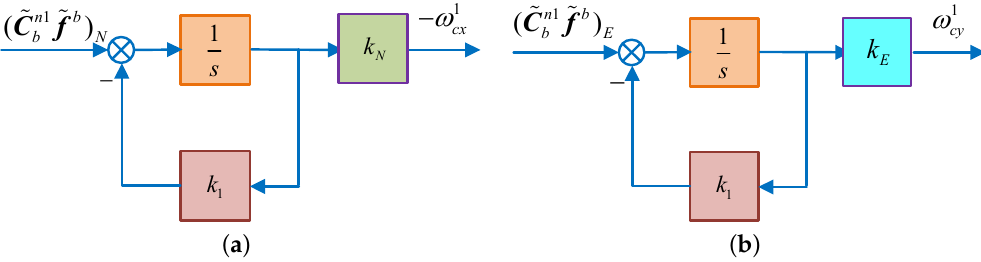
Figure 5. The schematic diagram of control angular rate in System 1. ( a ) Schematic diagram of calculating ω 1 cx ; ( b ) schematic diagram of calculating ω 1 cy